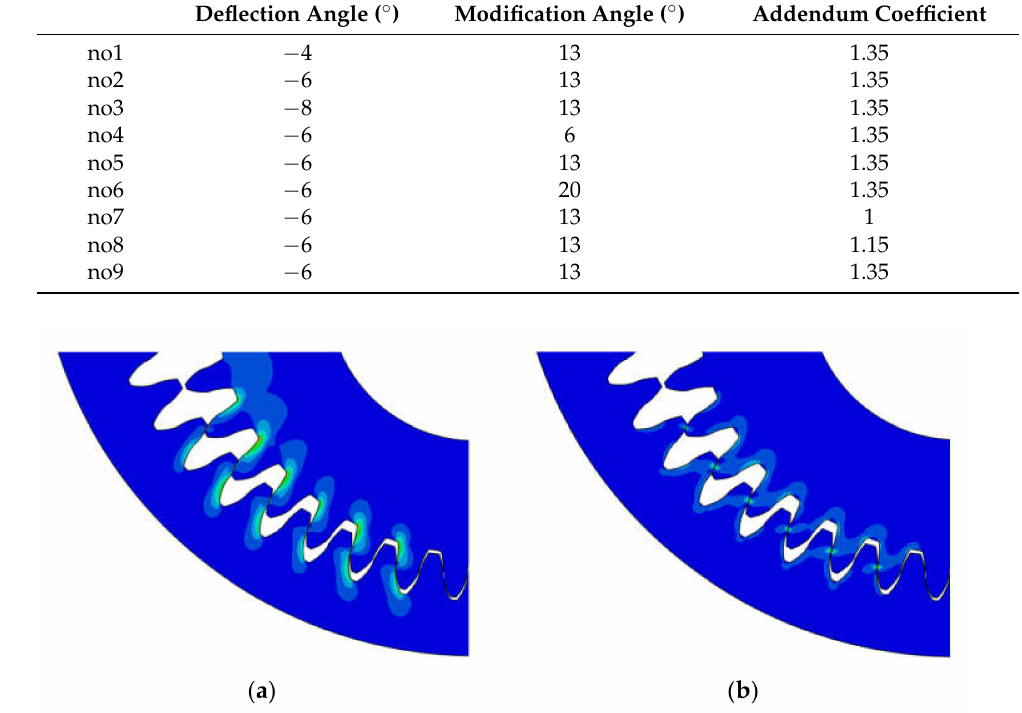
Table 2. Variable of parametric study for HCR gear drive.